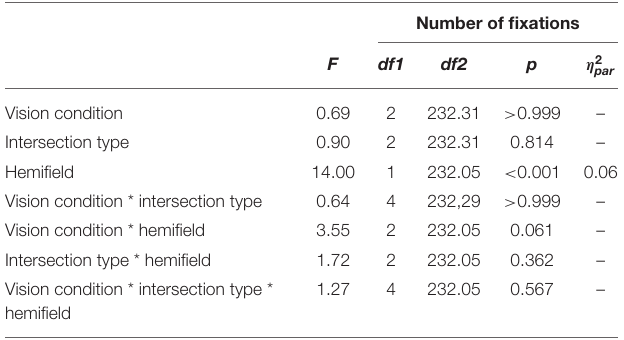
TABLE 8 | Mean and standard deviation of a subjective safety rating for each vision